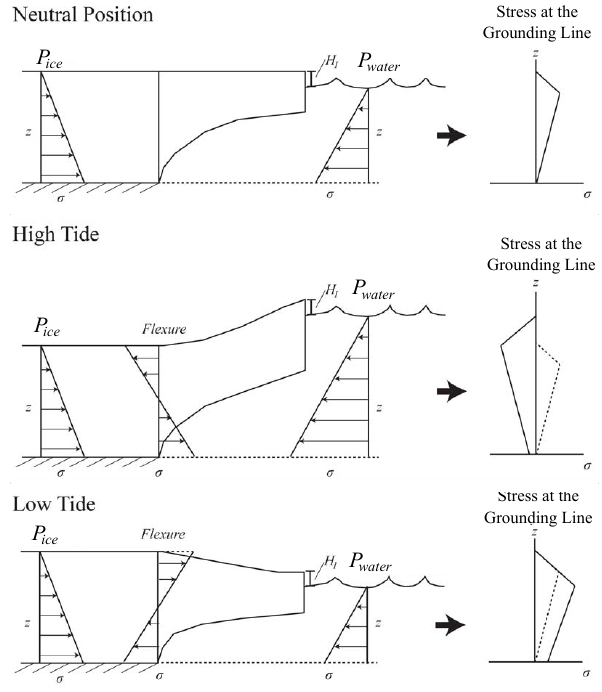
Figure C1. Schematic diagrams of the full tidal forcing condition at a neutral, high, and low tide. The tidal stress will be the ex- tensional/compressional stress due to the difference in hydrostatic pressure at the edge of the ice shelf (shown in the graph on the right of the figure) and the flexural stresses due to the presence of the ice shelf. H I is the distance between the surface of the ice shelf and the surface of the